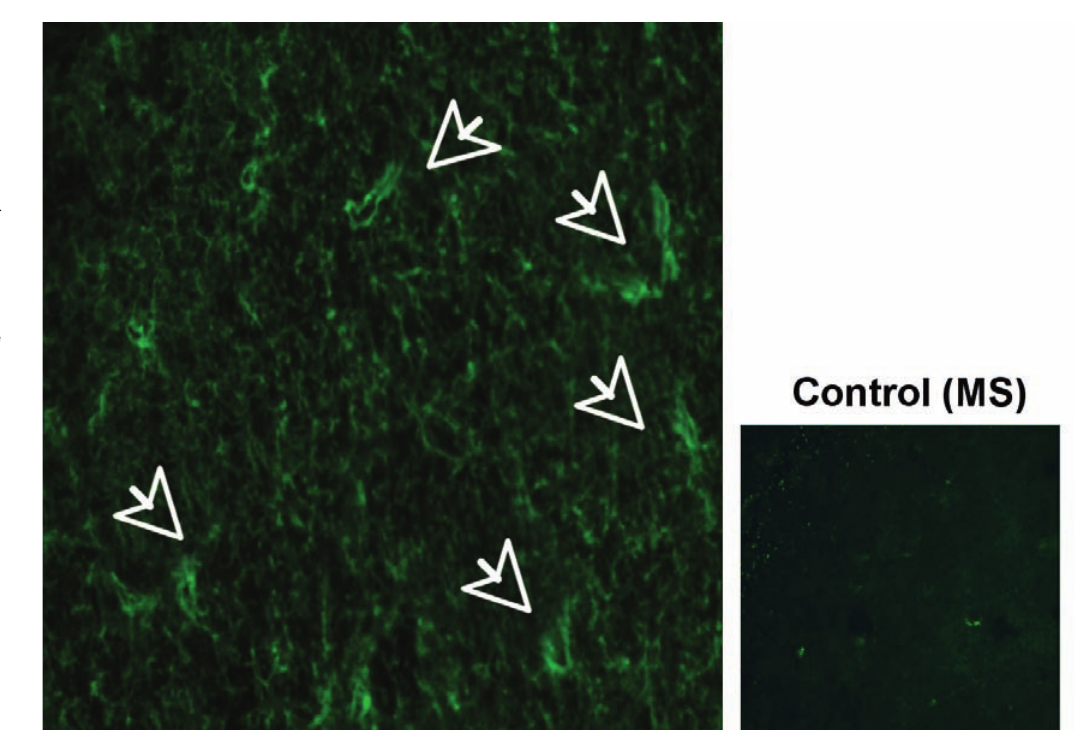
Figure 3 NMO test. Immuno- fluorescent staining of serum IgG from a NMO patient. Serum is diluted 1/100 and applied on tissue from monkey’s brain. Anti-NMO IgG are re- vealed by a 2nd anti human IgG (magni- tude x 200). The CNS microvessels of the blood brain barrier are targeted by these NMO-IgG (arrows). Control: MS serum at the same dilution (personal data).